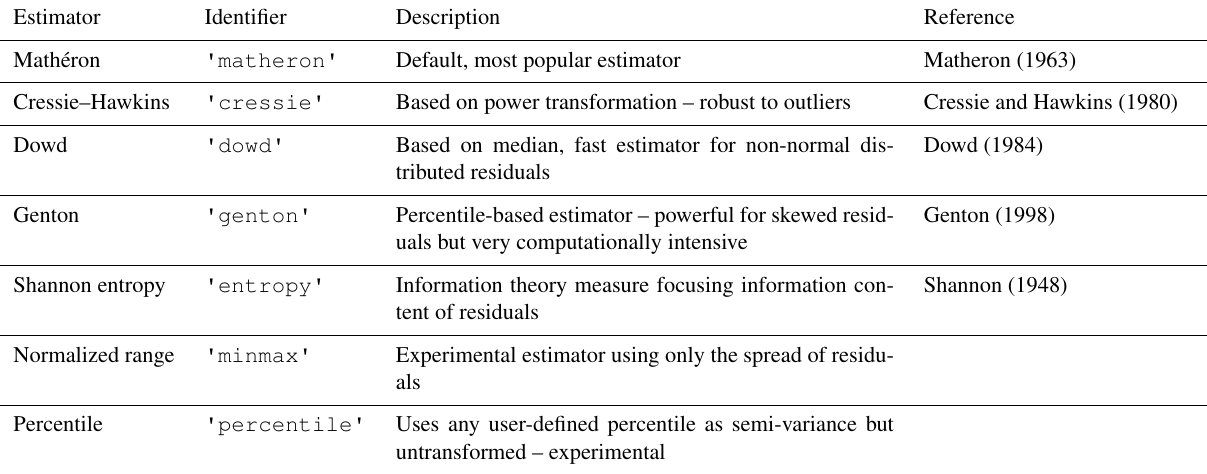
Table 1. Overview of all semi-variance estimator functions implemented in SciKit-GStat. Using Normalized Range and Percentile is only advised to users understanding the implications as explained in Sect. 4.1.3.